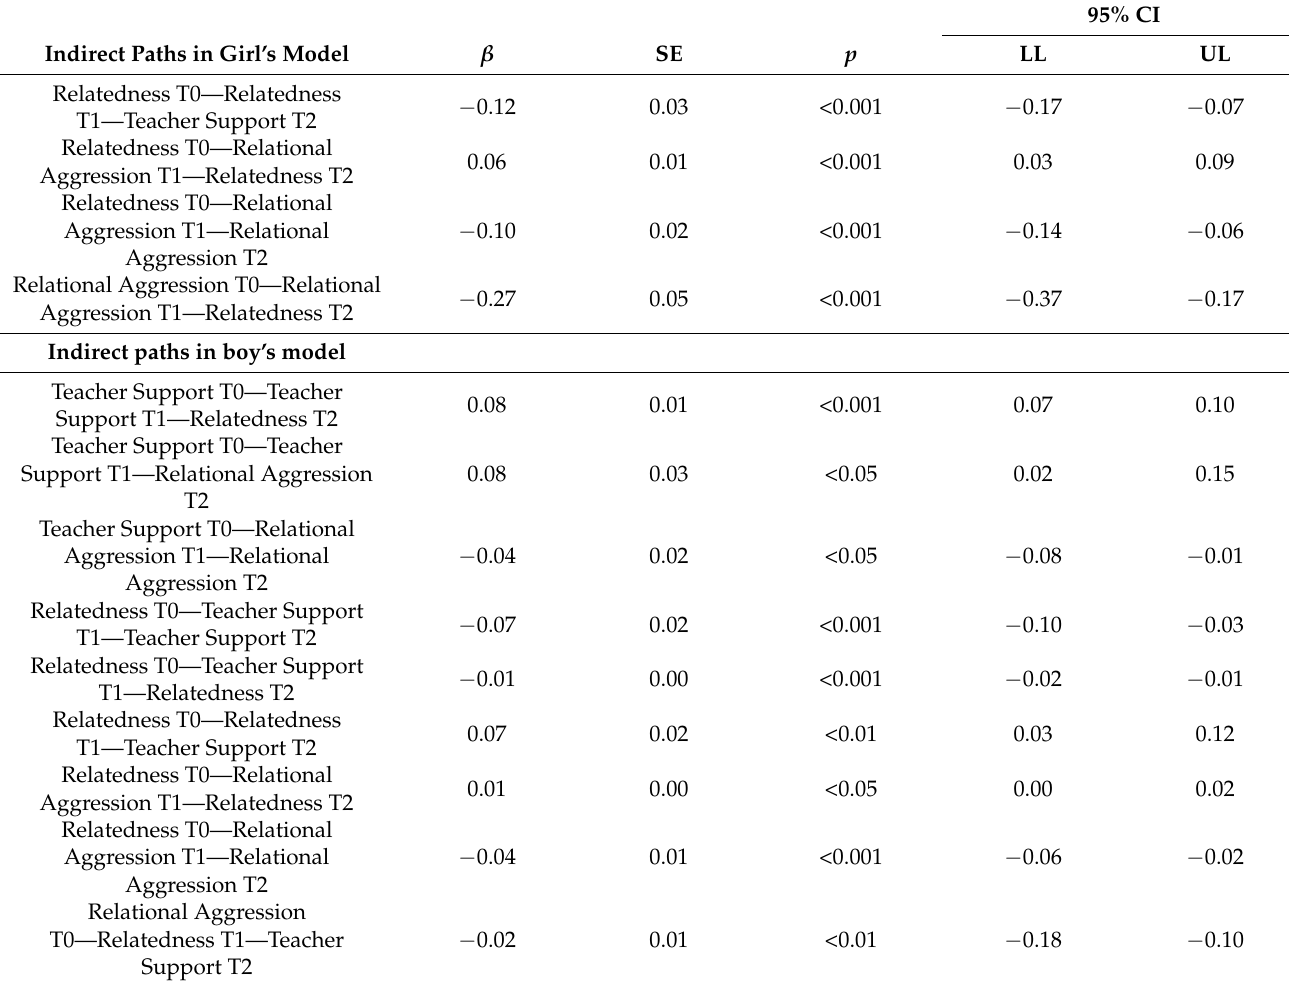
Table 4. Indirect effects in the relational aggression